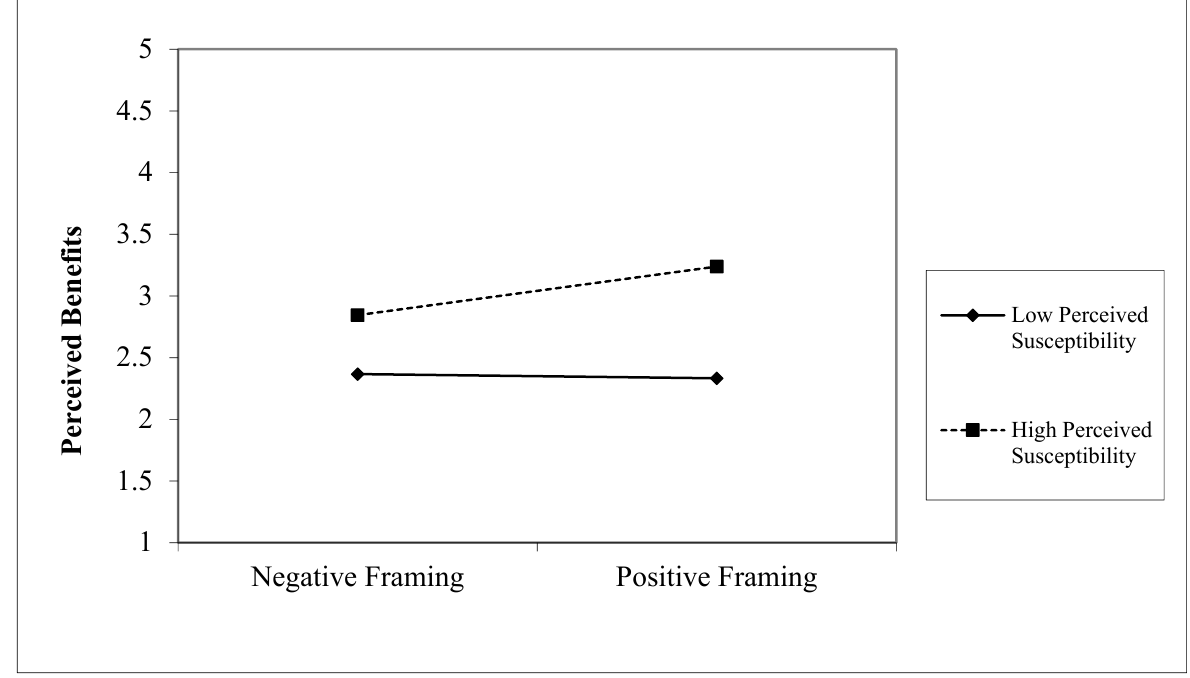
Figure 2. Results of simple slope analysis. Table 6. Results of hierarchical regression